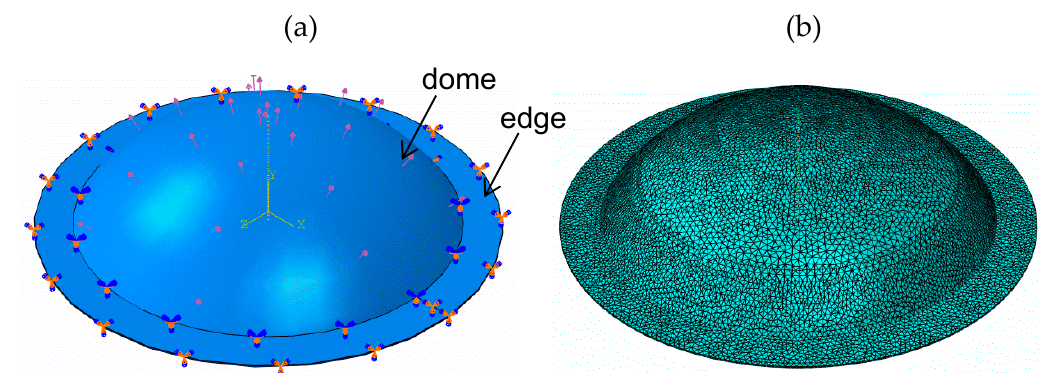
Figure 6. A schematic diagram of the load and boundary conditions set for the finite element analysis ( a ) and the corresponding finite element mesh ( b ).